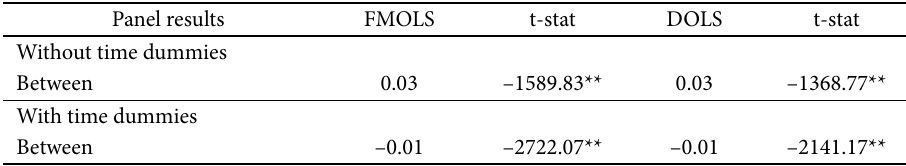
Table 4. FMOLS and DOLS group-mean panel test results Panel